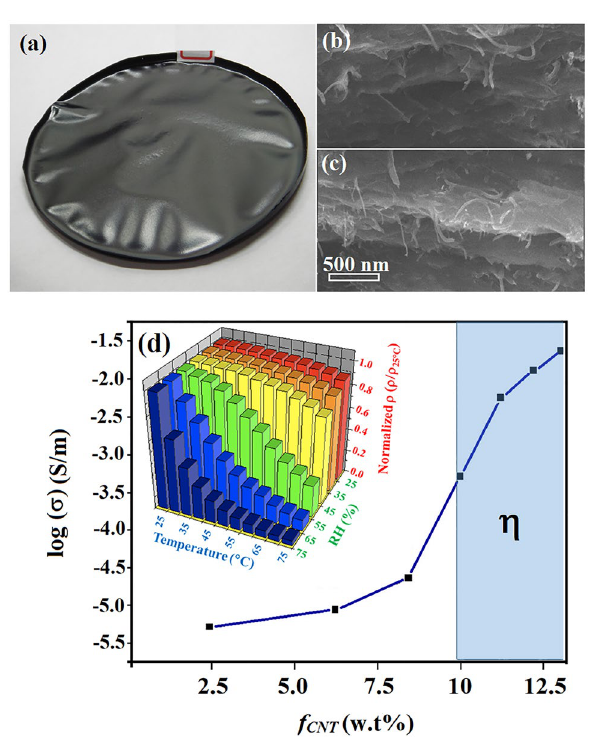
Figure 3. Optical image of as-made ( a ) and SEM images obtained from cross-section ( b – c ). The logσ- f CNT profile ( d ) and plots of normalized ρ v.s. T and RH (insert). Blue region denotes f CNT =